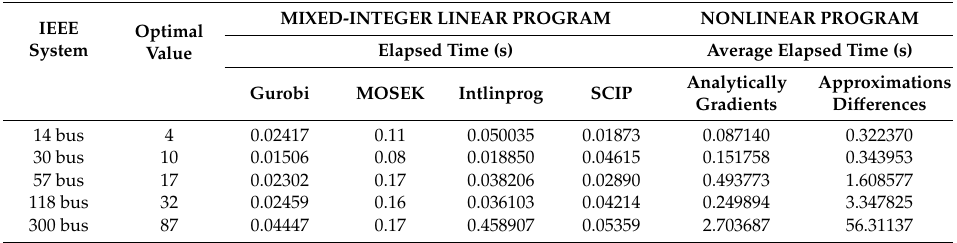
Table A5. Required PMU numbers and elapsed computational